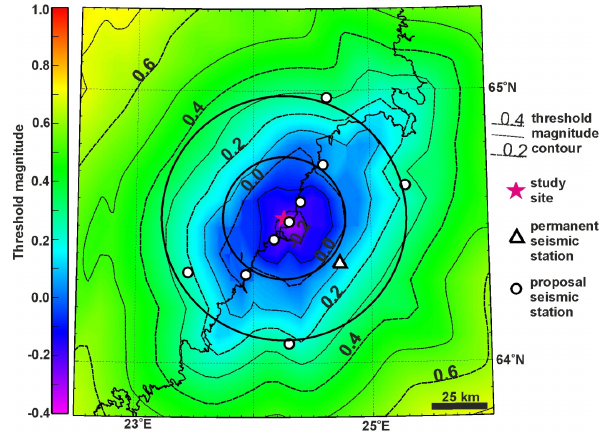
1 Figure 3. A map of the threshold magnitude (M th ) within a ten station network. Note that two 2 Fig. 3. A map of the threshold magnitude ( M th ) within a ten station offshore stations on small islands increase symmetry and lower the M th values along the coast 3 network. Note that two offshore stations on small islands increase and offshore. Concentric circles around the site show the survey area. 4 symmetry and lower the M th values along the coast and offshore. Concentric circles around the site show the survey